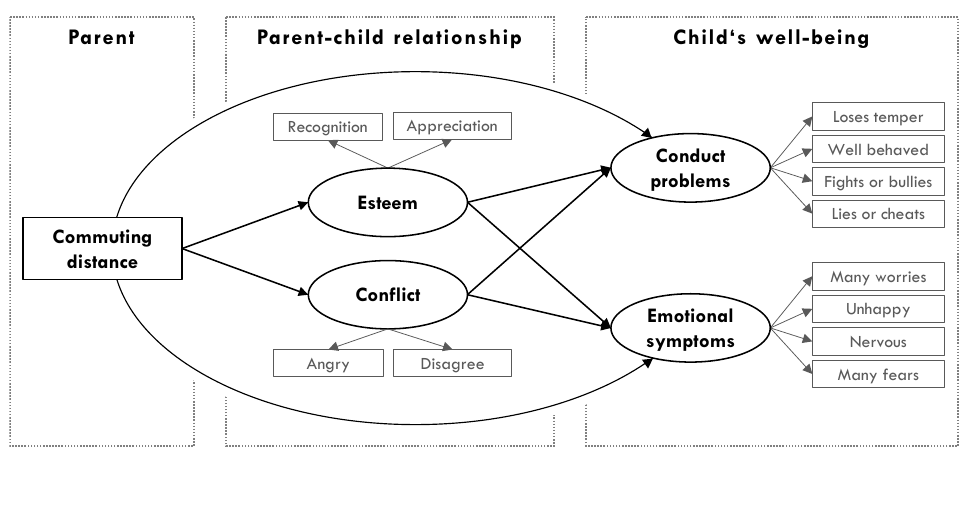
Figure 1 : Structural equation